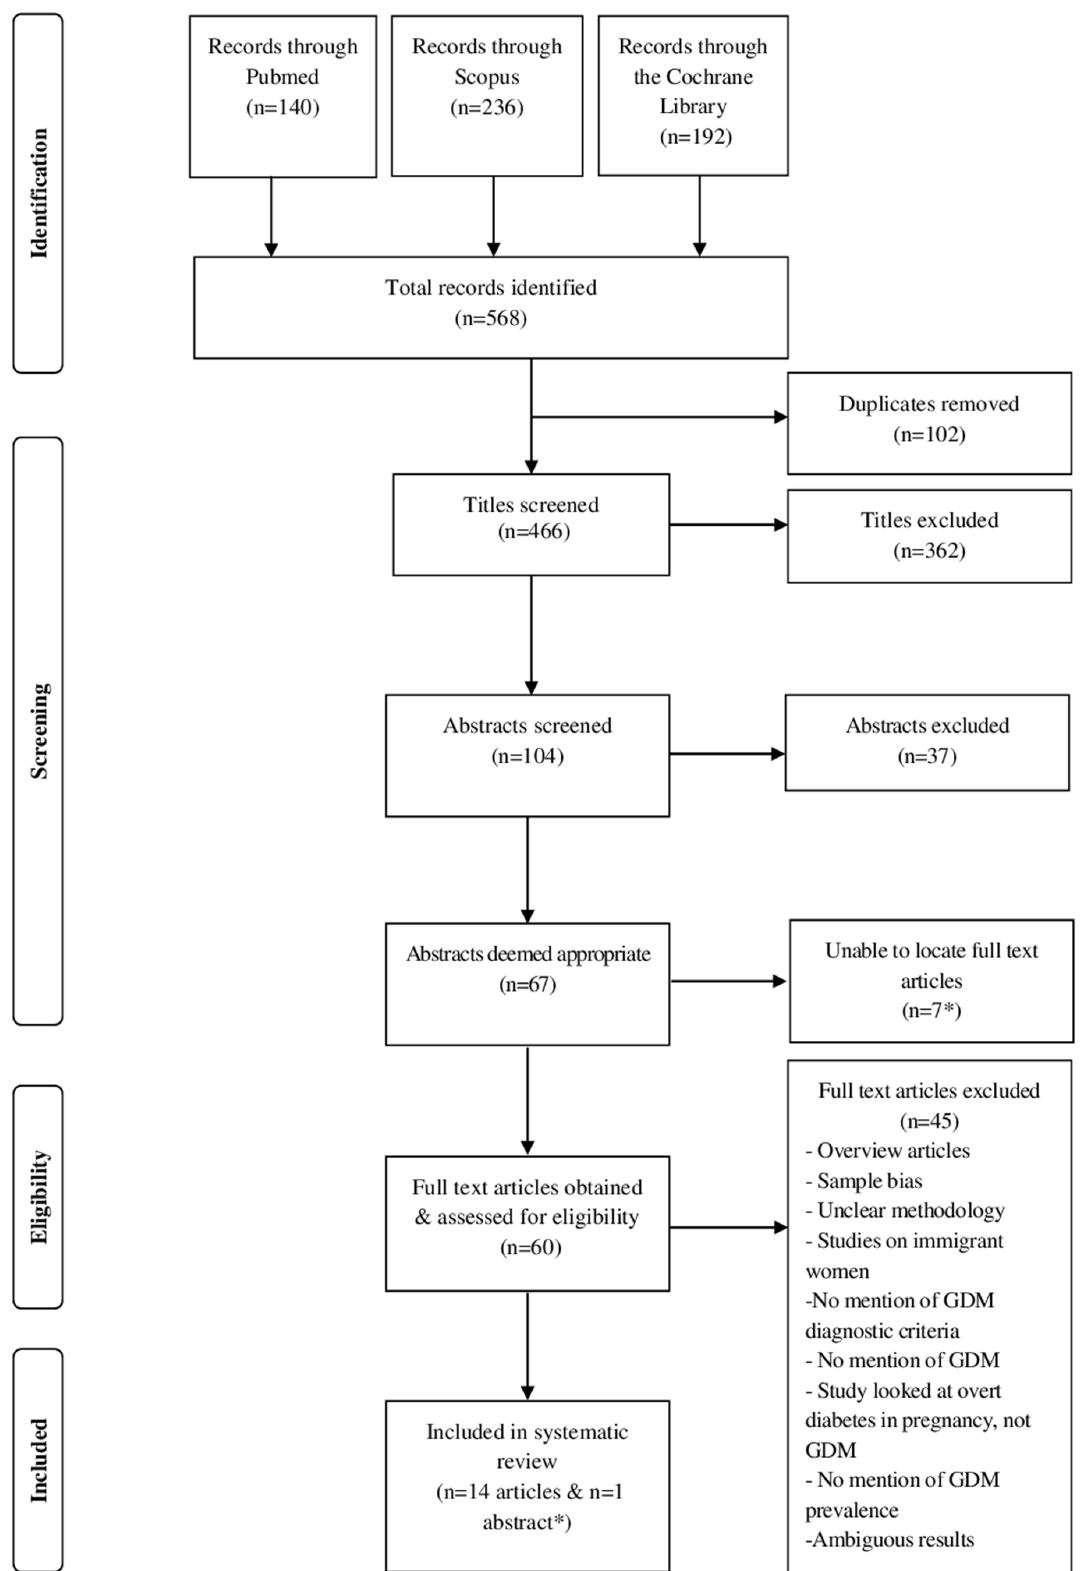
Figure 1. Flow diagram illustrating the number of included and excluded studies in the systematic review on gestational diabetes mellitus in Africa.